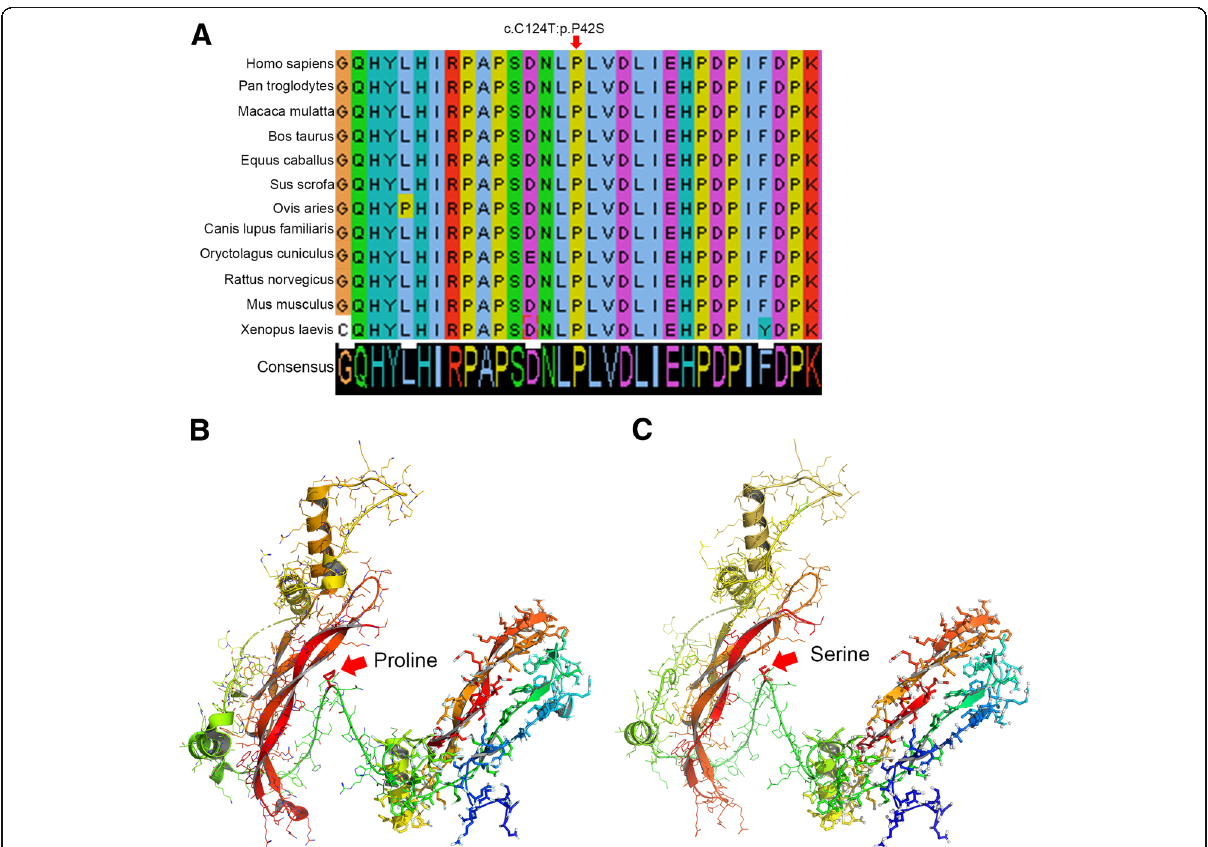
Fig. 4 Three-dimensional model of noggin-BMP7 tetramer. a Alignment of noggin amino-acid sequences from multiple species. The affected amino-acid site affected by our novel mutation is highly conserved during evolution. b Wild-type 3D model of the noggin dimer; BMP7 dimer is on the right. The red arrow indicates position 42 of noggin. c Mutation 3D model. On the left is the noggin dimer with c.124C > T, p.(Pro42Ser) mutation; BMP7 dimer is on the right. The red arrow indicates position 42 of